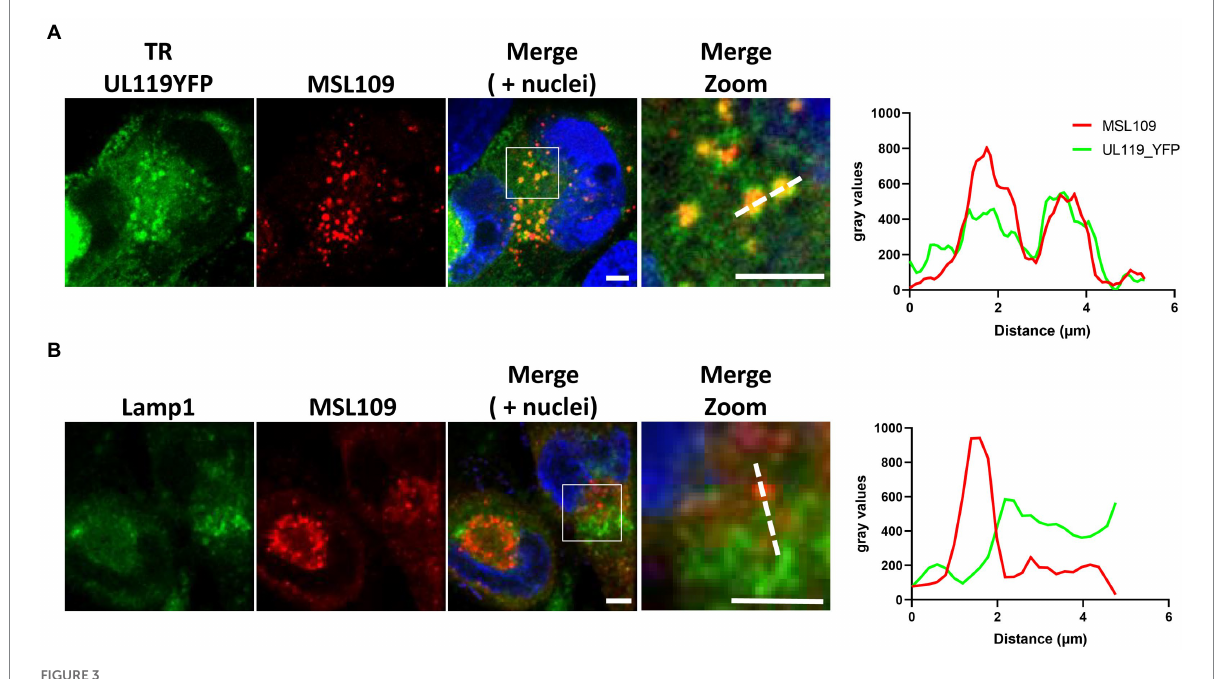
FIGURE 3 HFF-1 were infected with TR-UL119_YFP and 2 d.p.i incubated with 6.6 μg/ml of human anti-gH antibody MSL-109 for additional 3 days before being fixed, permeabilized, and stained. Secondary antibody Alexa fluor 647 conjugated anti-human was used to detect human antibodies (Red). Lysosomes were stained with anti-Lamp1 antibody. YFP and lamp1 signals are shown in green ( A,B panels, respectively). Signal intensity profiles along the dotted lines in the zoom panel are shown on the right. Scale bar: 5 μ